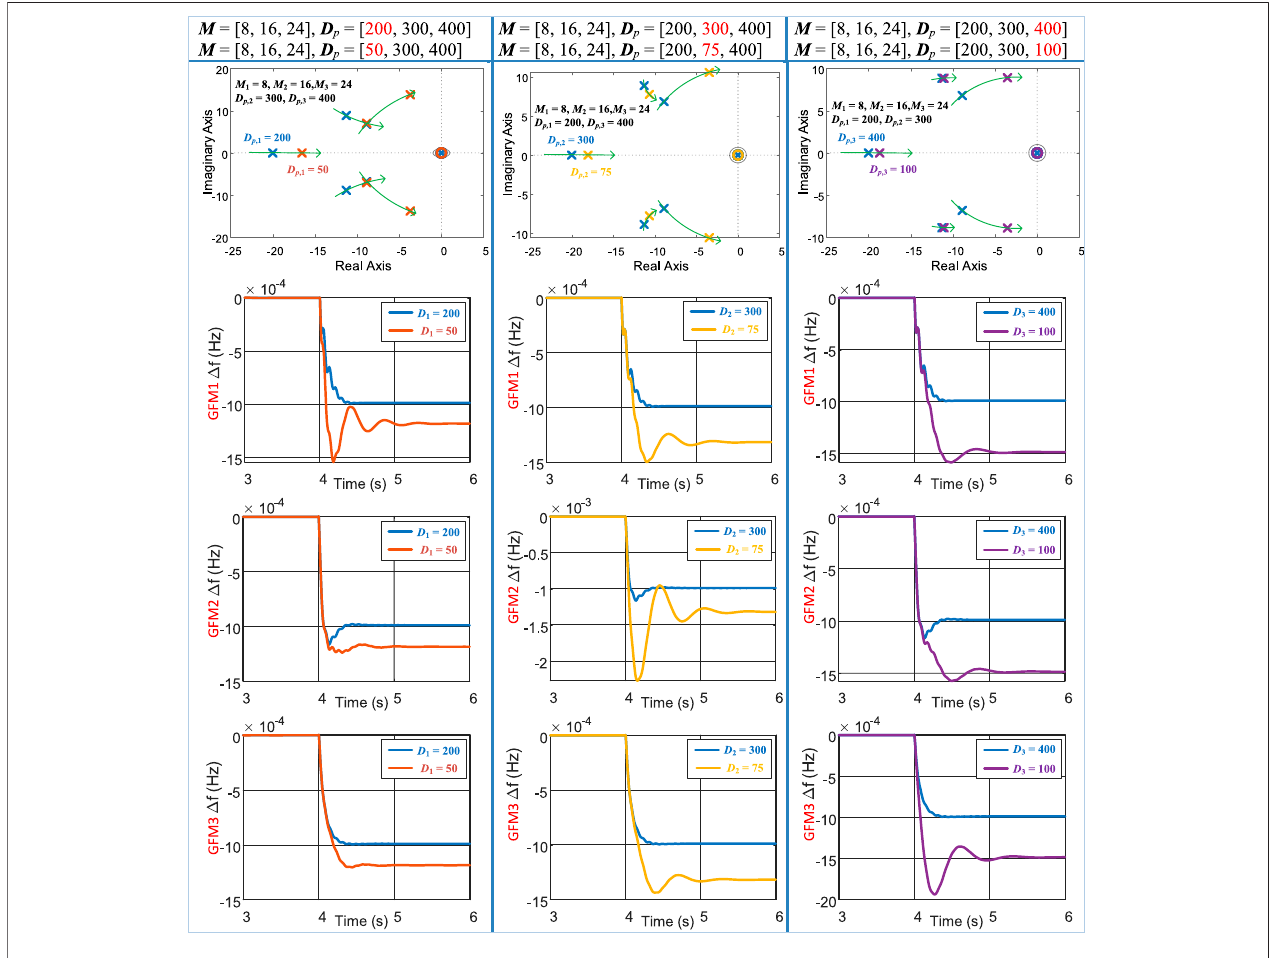
FIGURE 7 | Frequency response when the damping changes.